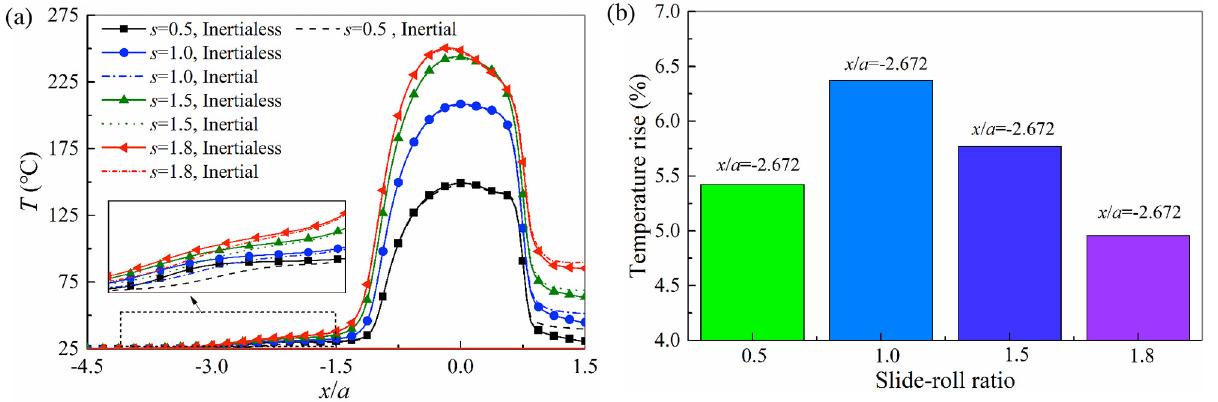
Fig. 16. Film temperature and its increment near inlet at varied slide-roll ratio s : (a) fi lm temperature, and (b) relative percentage rise of temperature rise near